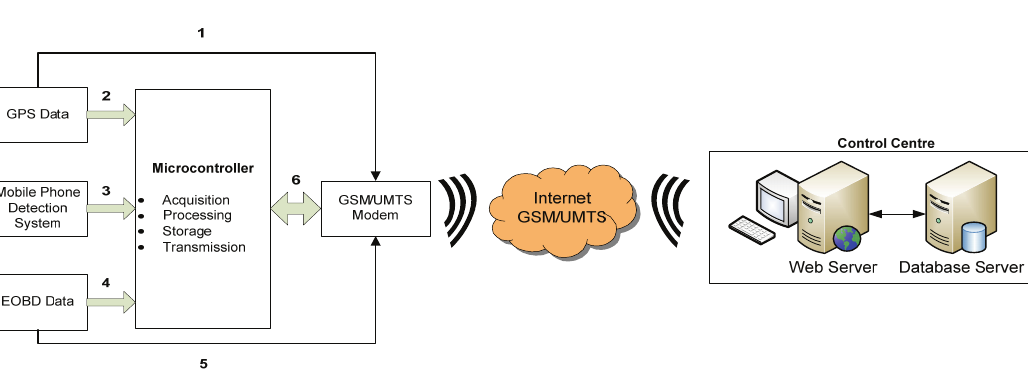
Figure 3. Information flow.